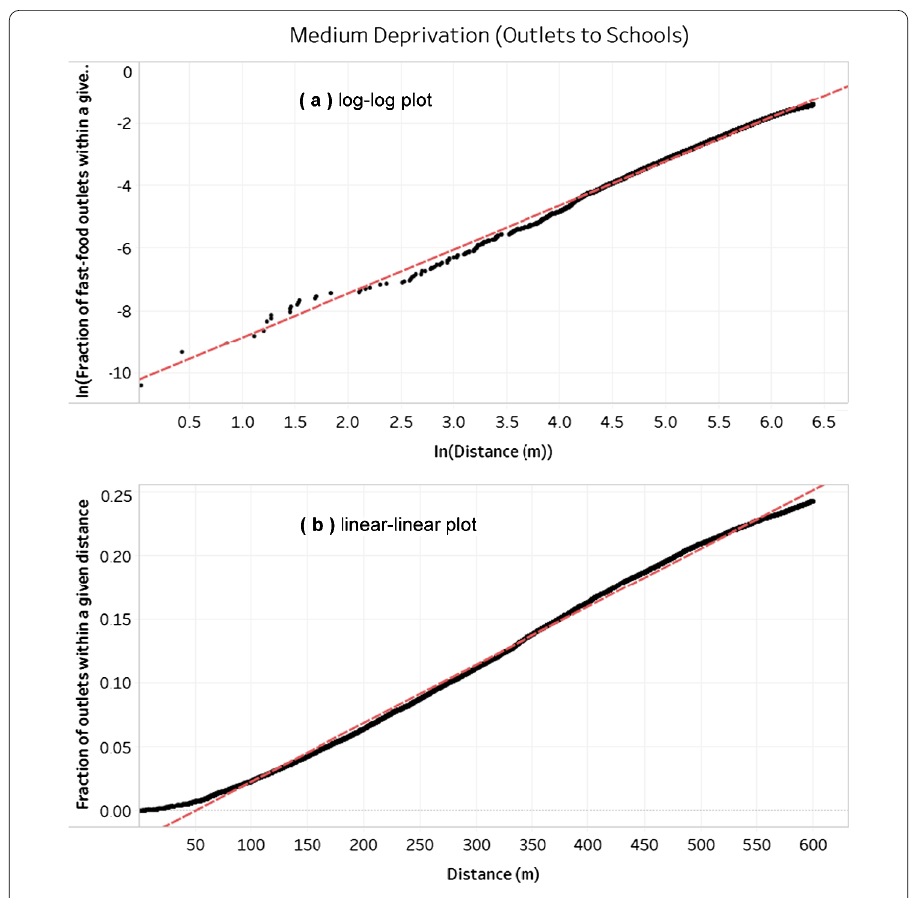
Figure 12 Fit between the analysis output (transformed from discrete to continuous) using a log-log plot ( a ) and a linear-linear plot ( b ), for a medium level of deprivation, for distances between fast-food outlets and schools. Anexpandedversionofthefigureshowingallfourcombinationsoflinearandlogarithmicscalesis availableon https://osf.io/gn3f2/